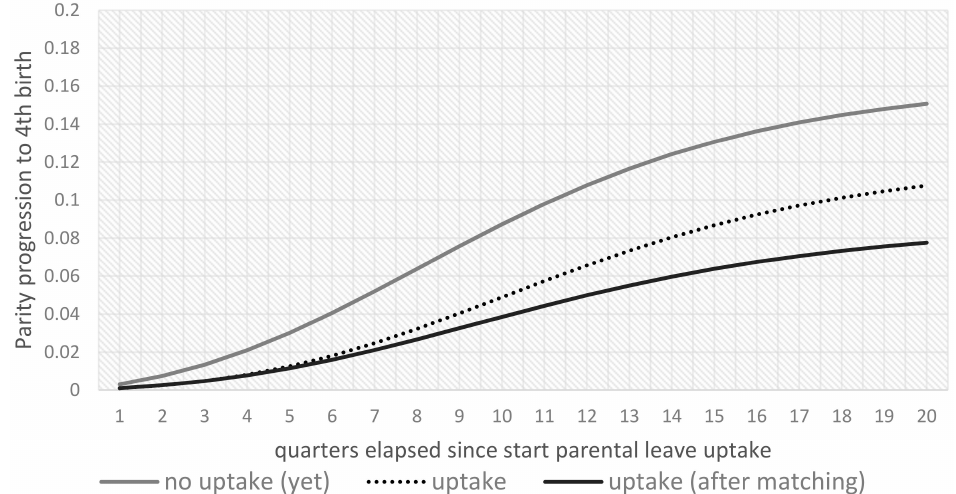
Figure 3. Leave uptake during the first year after childbirth and continued parity progression. Source data: Belgian Administrative Socio-Demographic panel (ASD